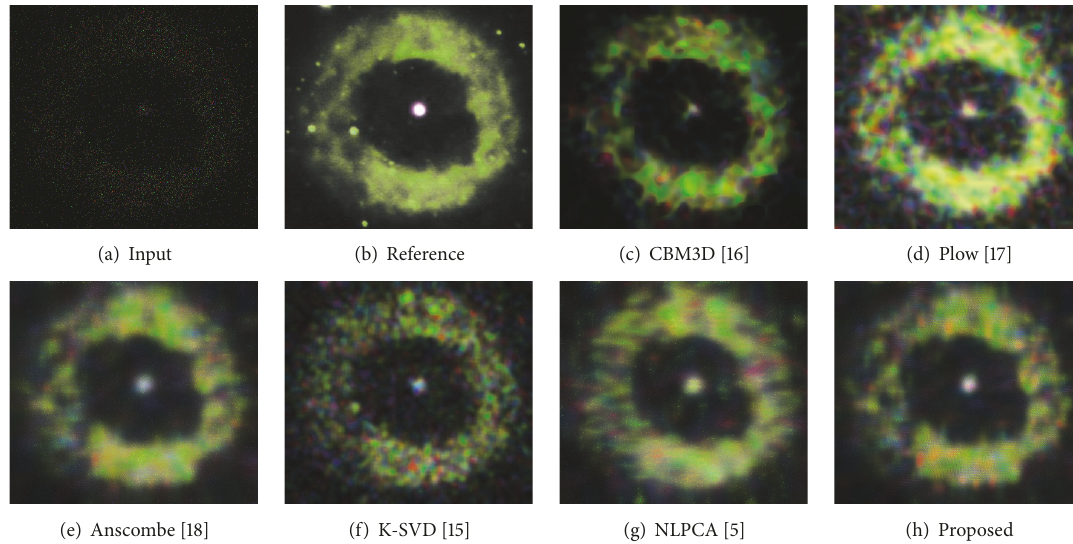
Figure 2: Nebula: noisy input, reference, and denoised images (for peak = 0.2).